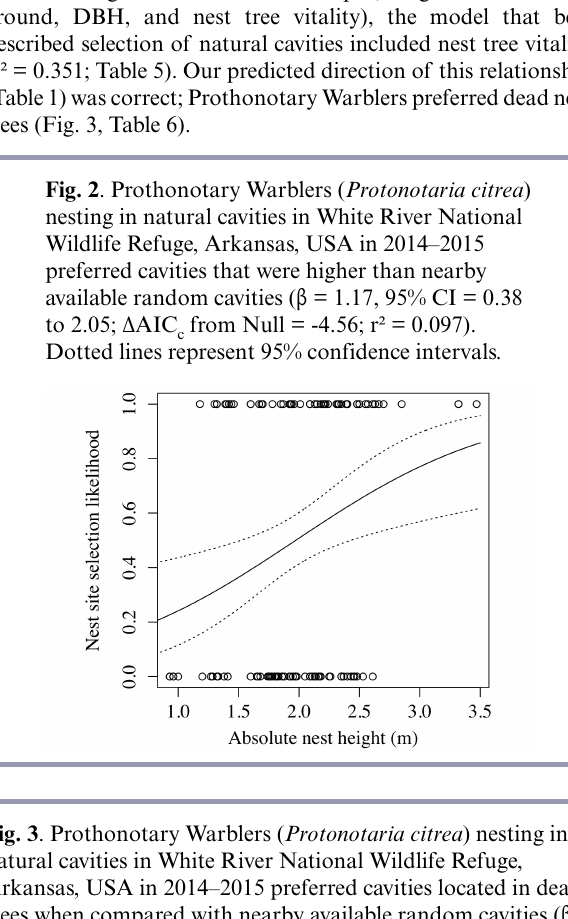
Fig. 3 . Prothonotary Warblers ( Protonotaria citrea ) nesting